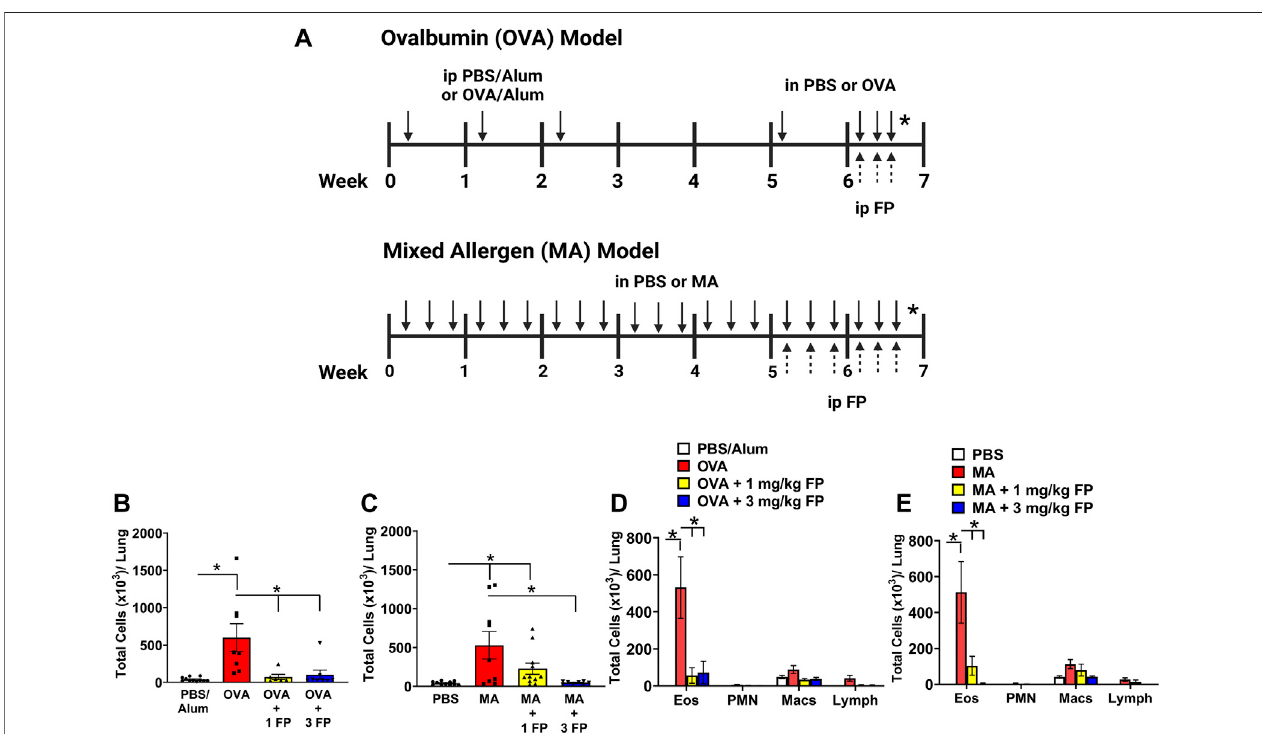
FIGURE1| Corticosteroids reduce totalairwayimmune cellandeosinophilicimmunecellin fi ltration inacute andchronic allergicairwayin fl ammation. (A) Foracute allergen model, mice were sensitized with PBS or ovalbumin (OVA) and aluminum hydroxide adjuvant (alum), and then intranasally challenged with OVA. Mice were treated with either vehicle, 1 or 3 mg/kg fl uticasone propionate (FP) by IP. For chronic allergen model, newborn mice were intranasally challenged with mixed allergen (MA) three times per week for 7 weeks. Mice were treated with either vehicle, 1 or 3 mg/kg FP by intraperitoneal injections 3 days a week during the last 2 weeks. Figure 1A was created using Biorender on 01/12/2022. (B) OVA- and (C) MA-challenged mice exhibited signi fi cantly higher total immune cell numbers in bronchoalveolar lavage. Total eosinophil numbers were signi fi cantly increased in (D) OVA- and (E) MA-challenged mice. Treatment with 1 mg/kg and 3 mg/kg FP signi fi cantly reduced total eosinophils in OVA- and MA-challenged mice. Data are presented as ± SEM, n = 6 – 11 mice per group. p < 0.05. * indicates signi fi cant difference between